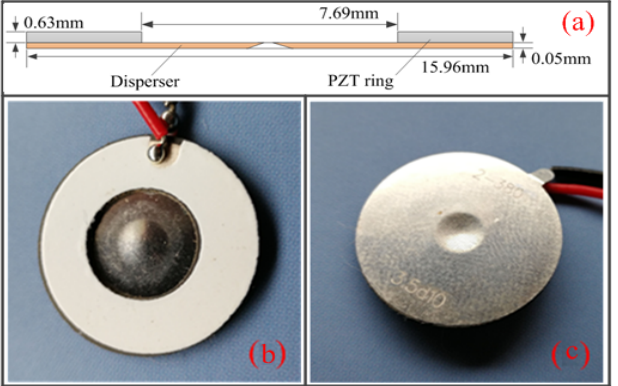
Figure 7. The morphology of the atomizing film. ( a ) Schematic diagram of the atomizing film structure; ( b ) front view of the atomizing film; ( c ) back view of the atomizing film [31].